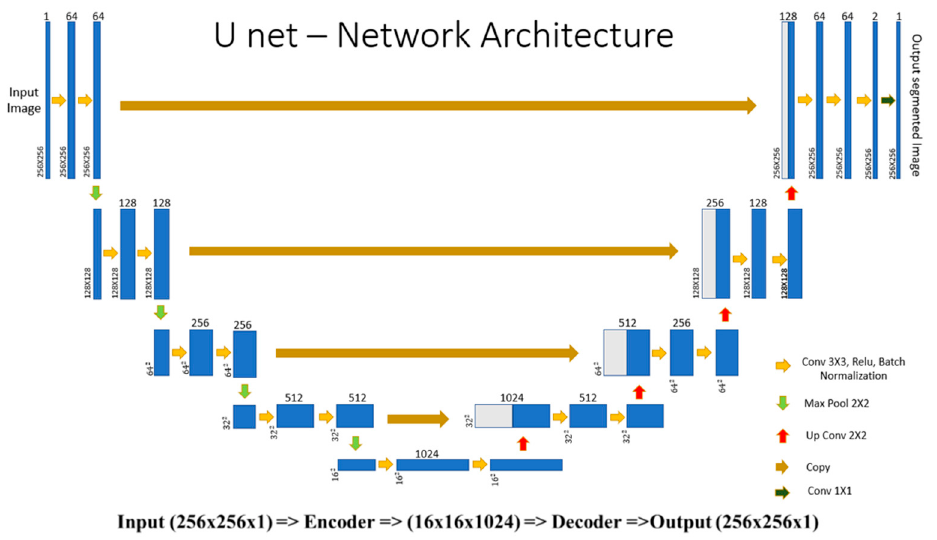
Figure 12. Implemented U-net architecture for the deep learning-based strategy for lane marking extraction (adapted from Ronneberger et al. [17]).